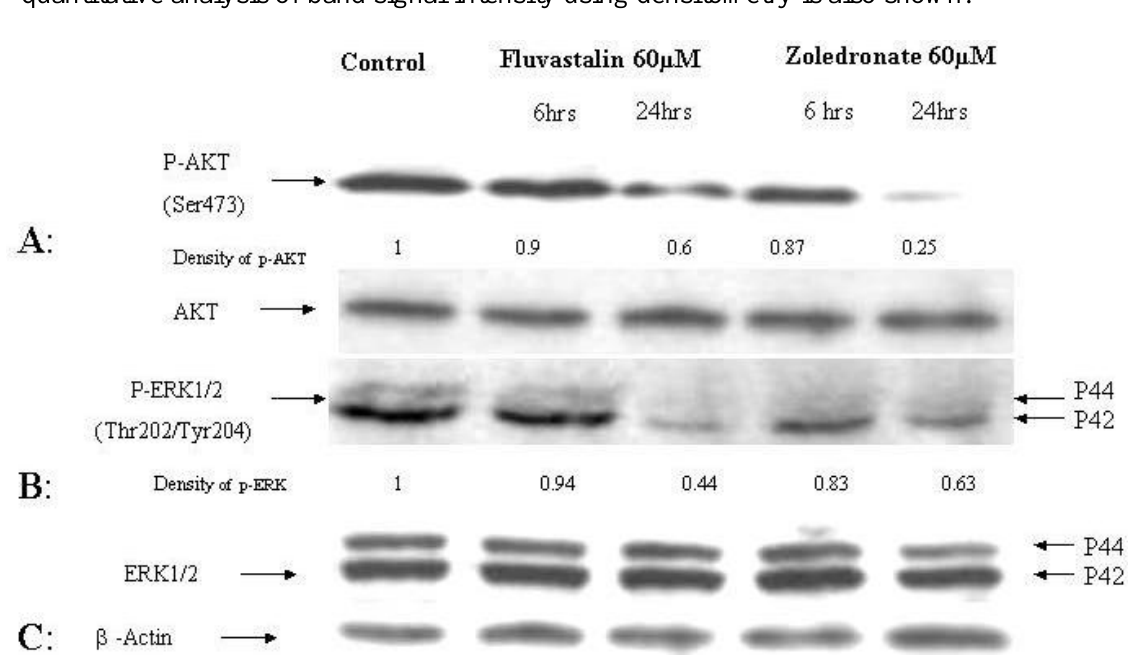
Figure 4. Inhibition of phosphorylation of ERK and AKT by fluvastatin and zoledronic acid. p-AKT (A) and p-ERK1/2 (B) level in T24 cells treated by fluvastatin and zoledronic acid versus control (medium only). β-actin is used as a loading control (C). Semi- quantitative analysis of band signal intensity using densitometry is also shown.